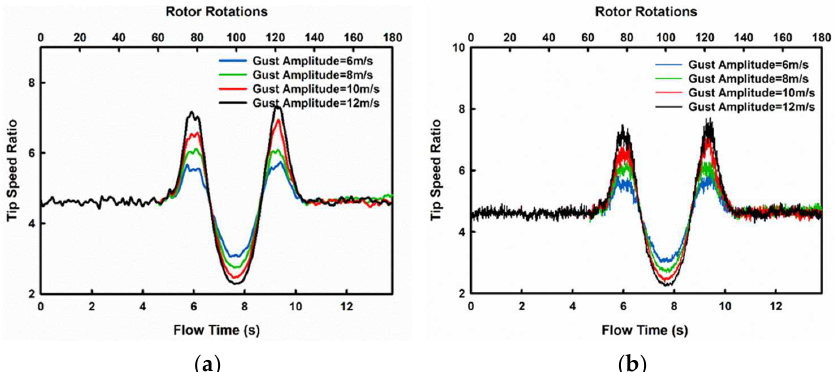
Figure 18. ( a ) The variation in cycle-averaged tip speed ratio for Ugust = 6 m/s, 8 m/s, 10 m/s, and 12 m/s; ( b ) Instantaneous variation of tip speed ratio for Ugust = 6 m/s, 8 m/s, 10 m/s and 12 m/s. In Figure 19, the variation of C m vs. azimuthal angle for a single blade for U gust cases of 6 m/s, 8 m/s, 10 m/s, and 12 m/s is shown. It is observed that power produced by up- stream wind is greater than the power produced by downstream wind. Unlike the case with a steady inlet velocity of 10 m/s shown in Figure 8a, the C m vs. azimuthal angle for U gust cases shown in Figure 17 deviates from the general profile.